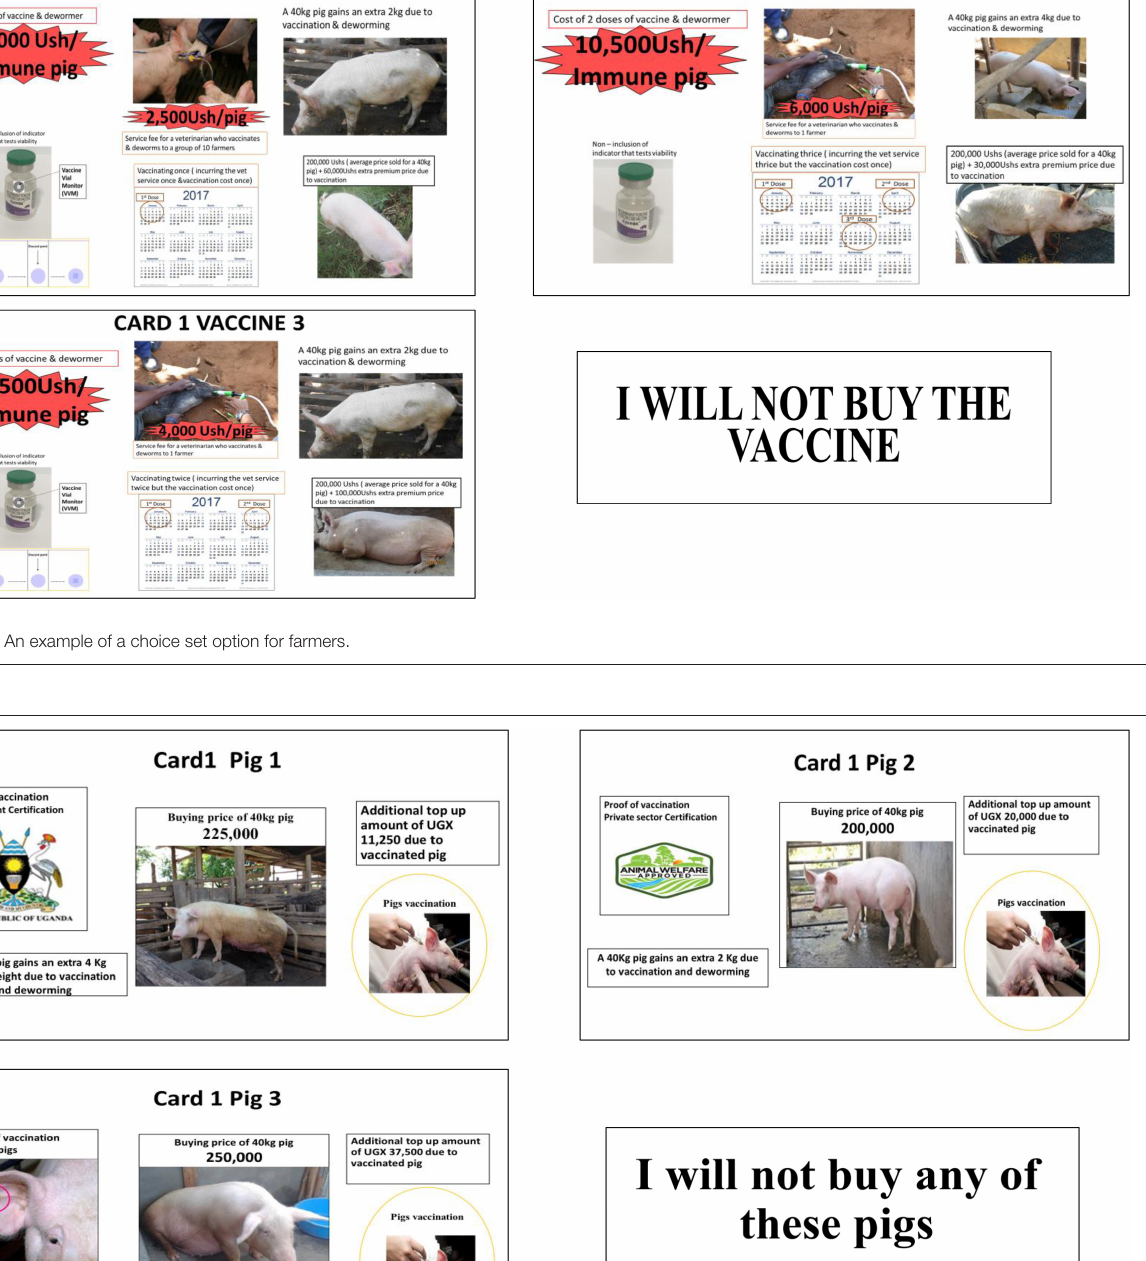
choose the most preferred vaccine option to purchase. Similarly, the traders were shown three choice options of vaccinated pigs for each of the eight choice sets. In each case, a “no-buy”